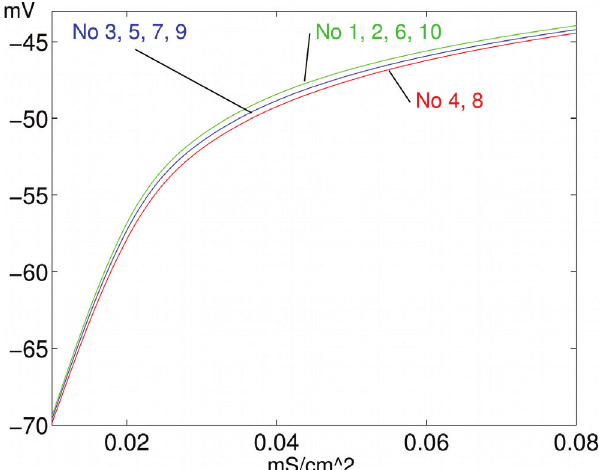
Figure 7. Negative pattern learning. Learning results in different activa tion functions for high (4, 8), medium (3, 5, 7, 9) and low (1, 2, 6, 10)